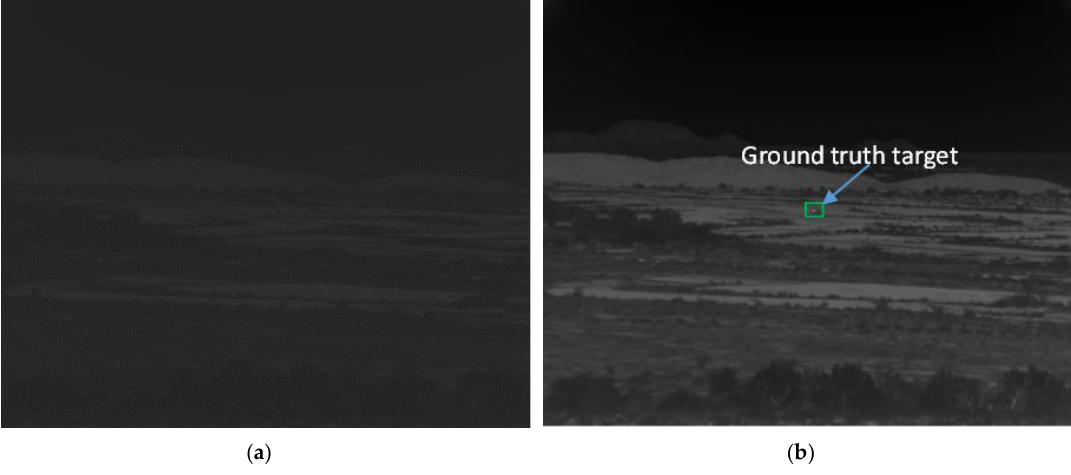
Figure A3. Before and after comparison of Approach 2. ( a ) Raw image; ( b ) Contrast-enhanced image.